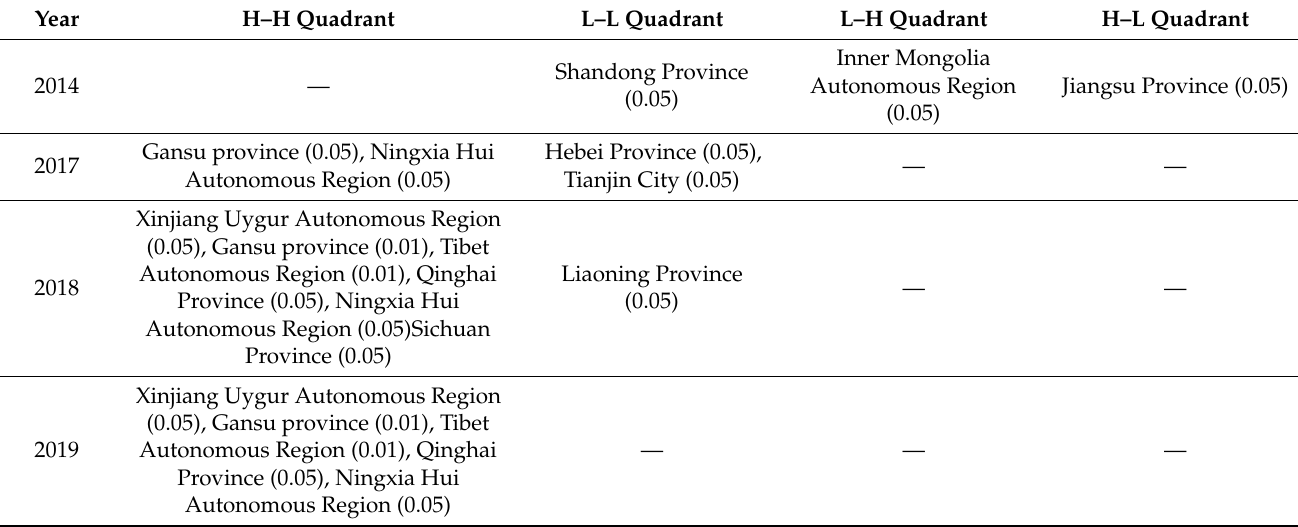
Figure 3. Changes in the overall Moran’s I index of the coordinated development level of China’s provincial PREE system. Source: own elaboration. Table 4. LISA clustering results of the coordinated development level of China’s provincial PREE system.